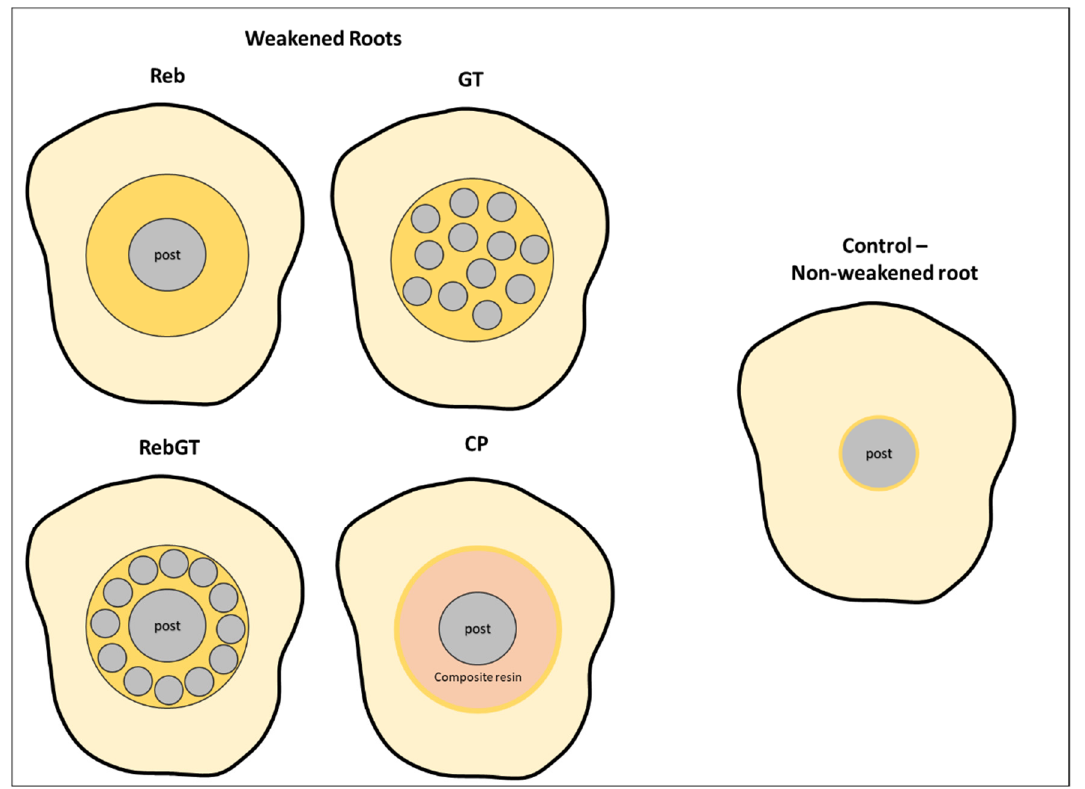
Figure 1. Schematic drawing of the post systems used. The weakened roots were enlarged with a diamond bur, leaving at least 2 mm of remaining dentin wall. In the figure, grey refers to the post, yellow to the resin cement used, and orange to the composite resin used to customize the post in CP group.